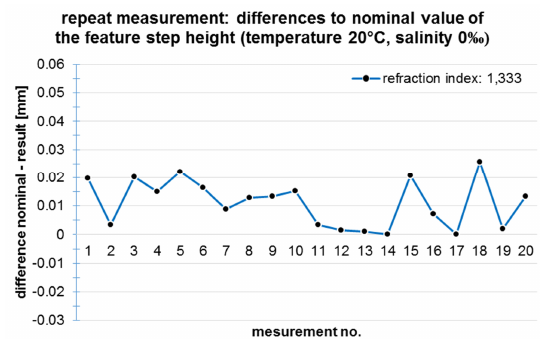
Figure 11. Results of a repeated measurement: differences to nominal step height of the reference object